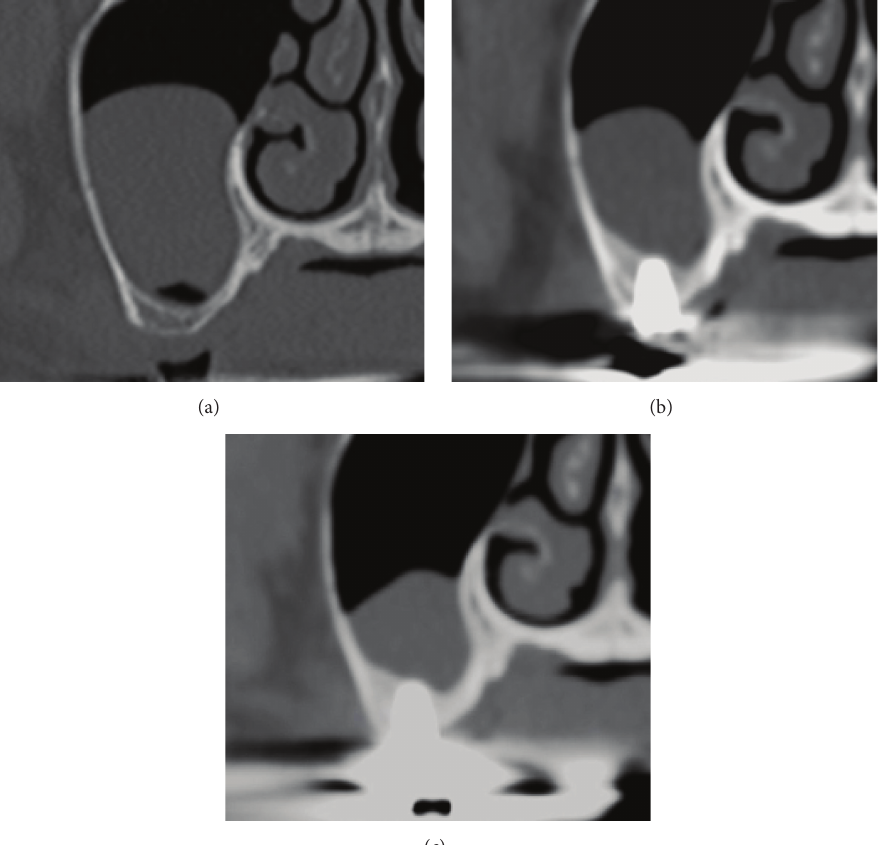
Figure2:CTscanswereperformedandshowedtheimplant(site16).(a)Apreoperativeimageshowstheresidualboneheightisapproximately 2 mm. (b) Six months after surgery, the original sinus floor was confirmed. Furthermore, gradually increasing radiopacity was observed around the implant up to the apex, which is the elevated site using PRF only. (c) One year after surgery, the original sinus floor is unclear and radiopacity around the implant increased.